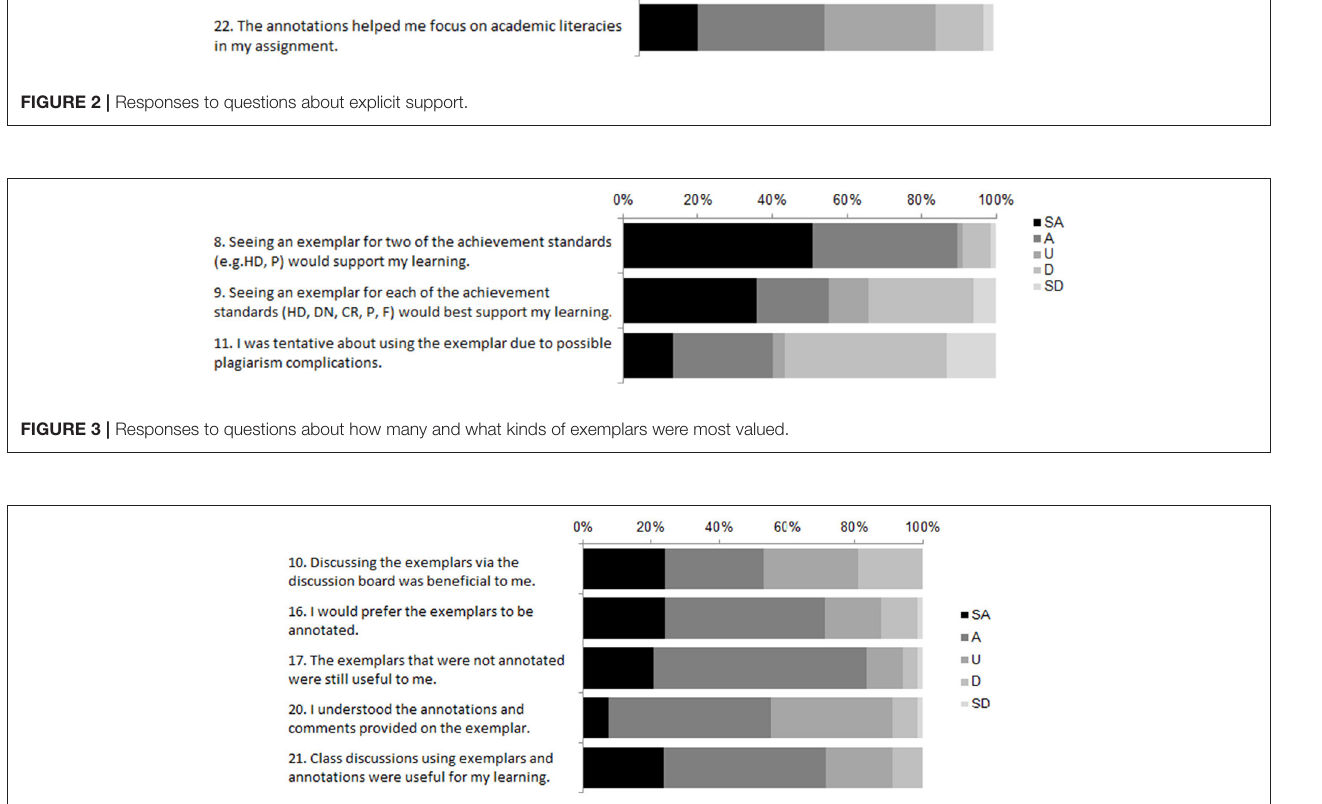
FIGURE 4 | Responses to questions about in-class discussion of